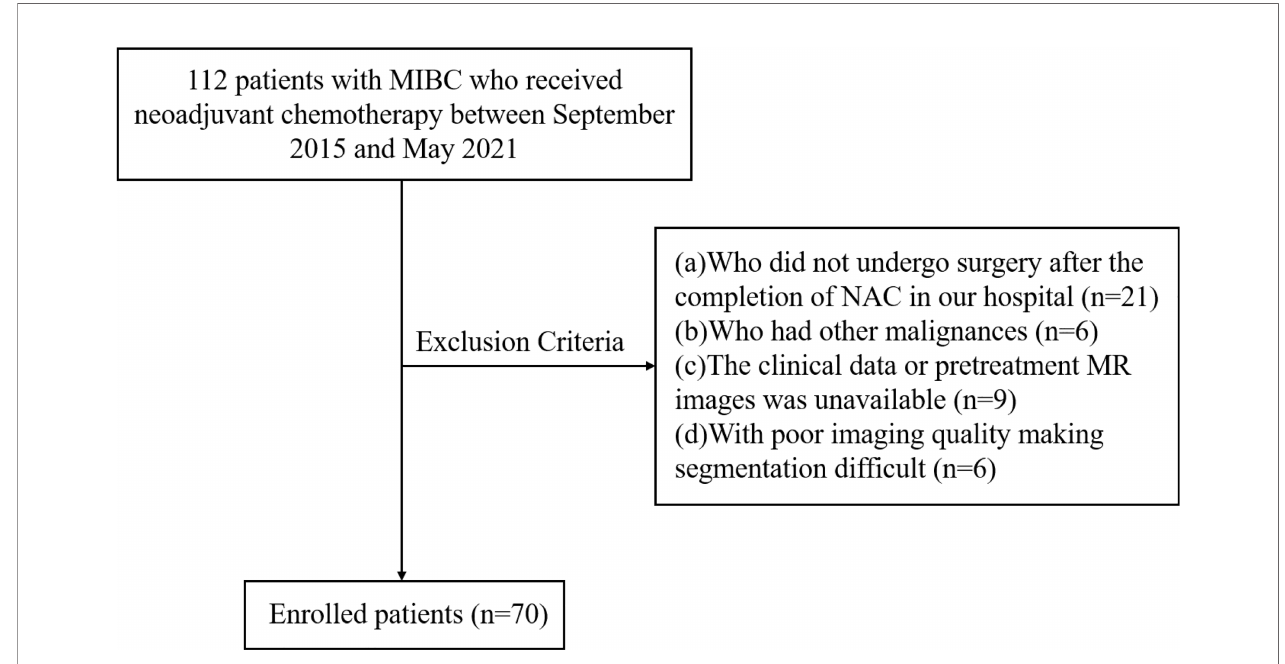
FIGURE 1 | Flowchart of study design. MIBC, muscle-invasive bladder